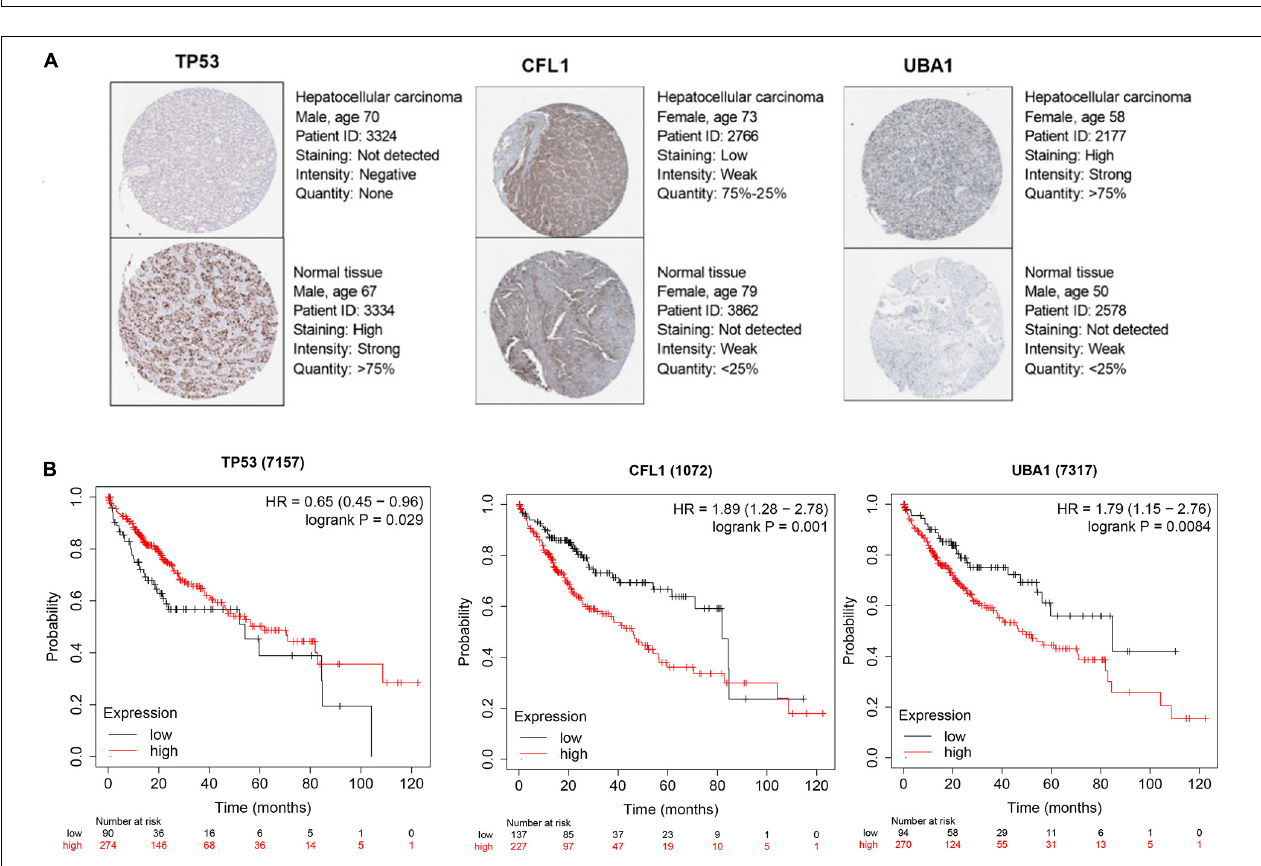
FIGURE 6 | Candidate hub genes selection for prognosis prediction of HCC patients. (A) Protein expression level of TP53, CFL1, and UBA1 certified by The Human Protein Atlas database. (B) Kaplan–Meier survival analysis of TP53 , CFL1 , and UBA1 from KMPLOT database. KMPLOT, Kaplan-Meier plotter.